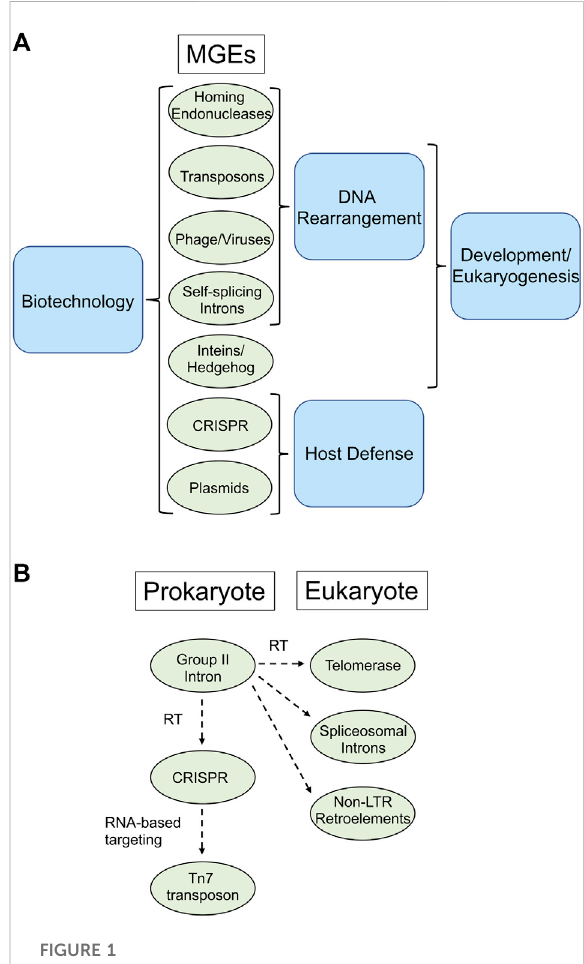
FIGURE 1 MGE ’ s repurposed by nature and biotechnologists. (A)